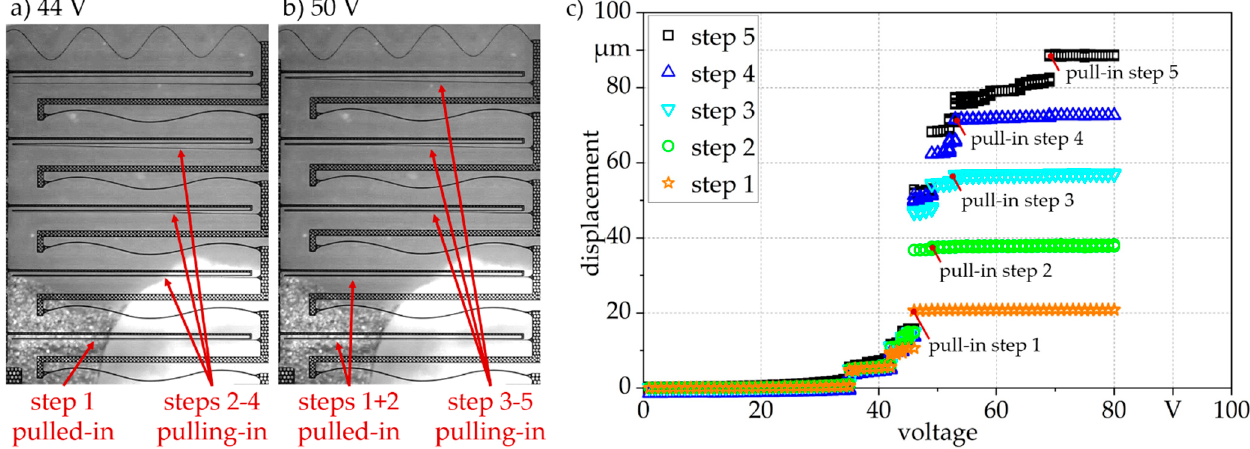
Figure 13. Collective actuation of system 2 at ( a ) 44 V, ( b ) 50 V, ( c ) experimental displacement of the single steps of system 2, the voltage is increased in 1 V-steps every 2 s.